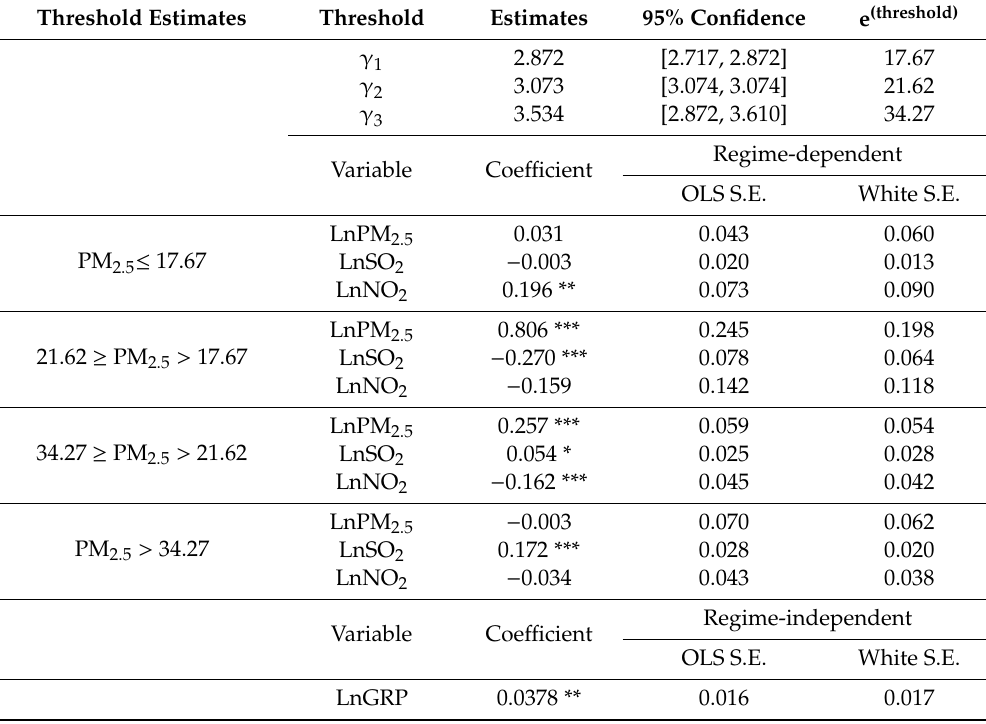
Table 5. Estimation results of PM 2.5 e ff ects on cardiovascular mortality.